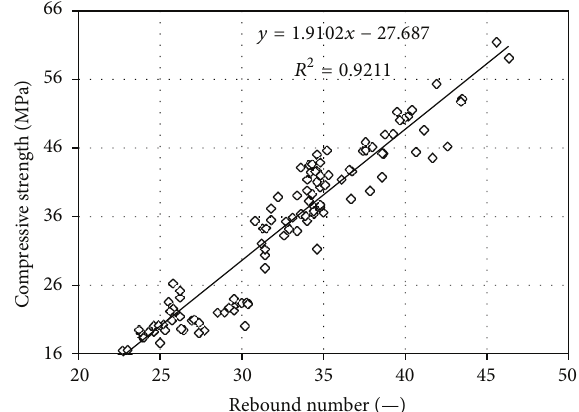
Figure 3: Results of measurements using the L-type Schmidt rebound hammer; relationship between the rebound number and compressive strength of calcium silicate